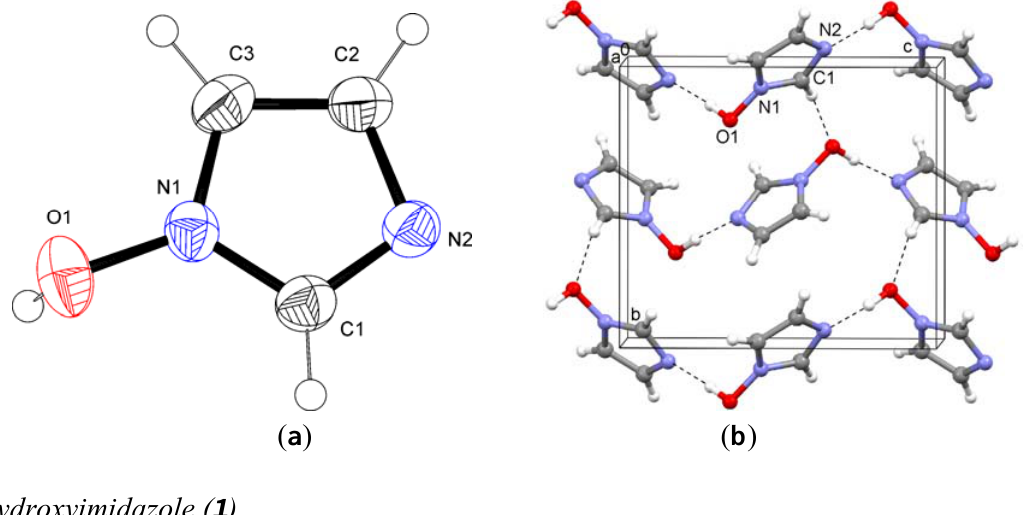
Figure 2. ( a ) ORTEP plot with numbering scheme and ( b ) hydrogen bonding in the crystal structure of 1-hydroxyimidazole ( 1